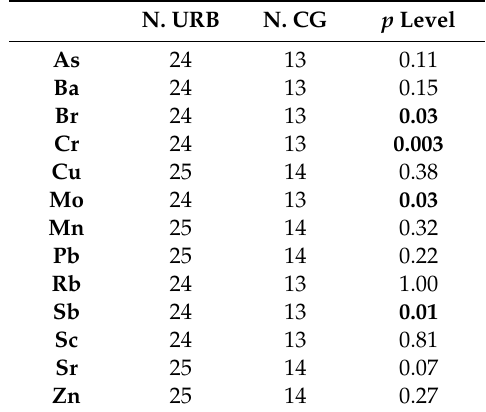
Table 4. Non-parametric Mann–Whitney test between leaf samples from urban and city-garden sites ( p < 0.05).